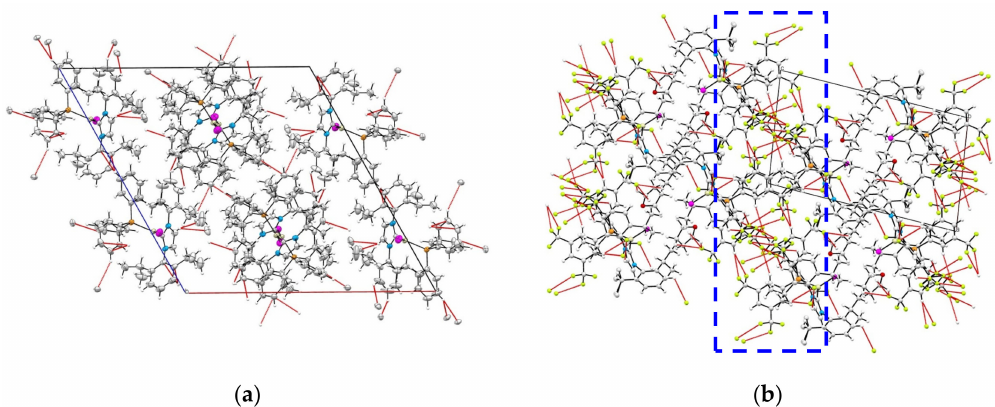
Figure 4. Crystal packing views from the (010) planes depicted using crystallographic data of ( a ) 2a and ( b ) 2c (pink: Br; gray: C; light green: F; red: O; orange: P; light yellow: Ni). Short contacts that are shorter than van der Waals radii are addressed as red lines. A blue dashed line in ( b ) highlighted a layer where many contacts containing F atoms (light green) are